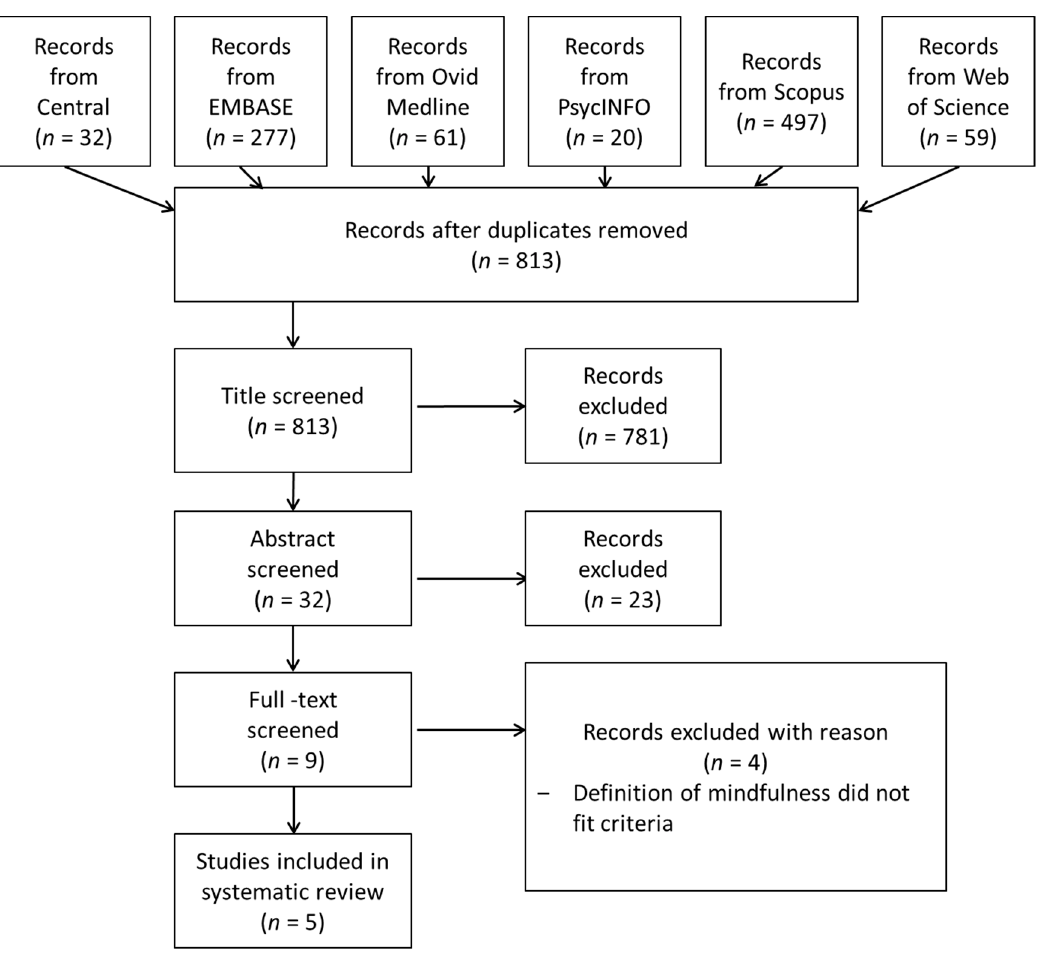
Figure 1. Flowchart of procedure. Central indicates the Cochrane Central Register of Controlled Trials database.